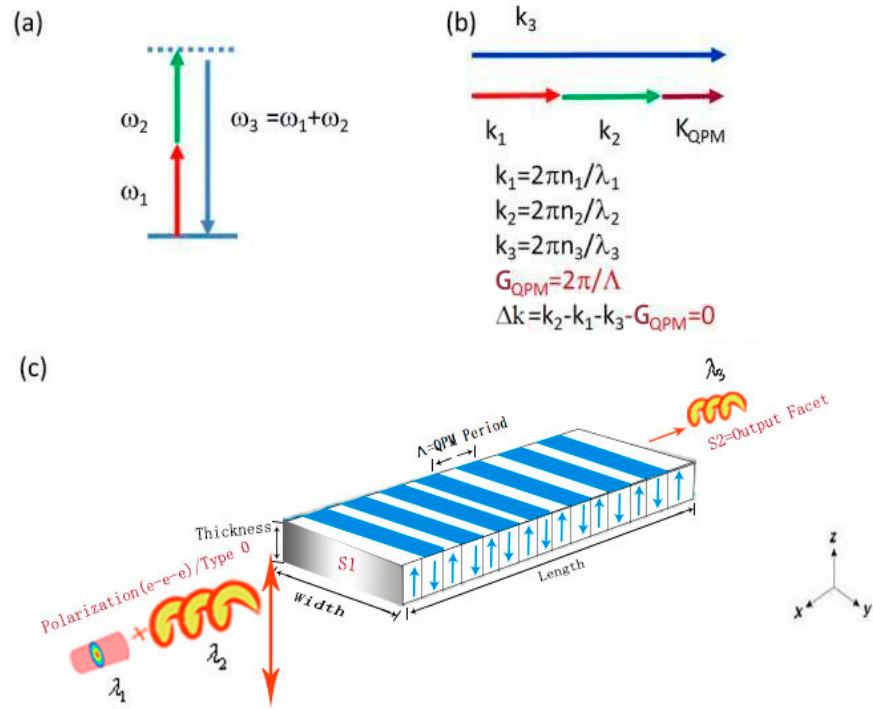
Figure 1. Schematic diagram of the experiment. ( a ) Photon Energy Conservation. ( b ) Photon Mo- mentum Conservation. ( c ) Periodically reverse domain with Period ⋀ , which creates wave vector G QPM == 2 / ⋀ for the quasi-phase-matching (QPM) interaction. The experimental optical path diagram is shown in Figure 2. The key optical compo- nents (abbreviations) of the optical path include the collimator, half-wave plate (HWP), periodically poled lithium niobate (PPLN) (the length of the crystal set to 50.0 mm, height 1.0 mm, and width 12.3 mm), polarization beam splitter (PBS), quarter-wave plate (QWP), camera (CCD), baffle (Baffle), filter (Filter), mirror (M), lens (L1–L4) ( f 1 = 100 mm, f 2 = 60 mm, f 3 = 45 mm, f 4 = 45 mm) and spatial light modulator (SLM). The